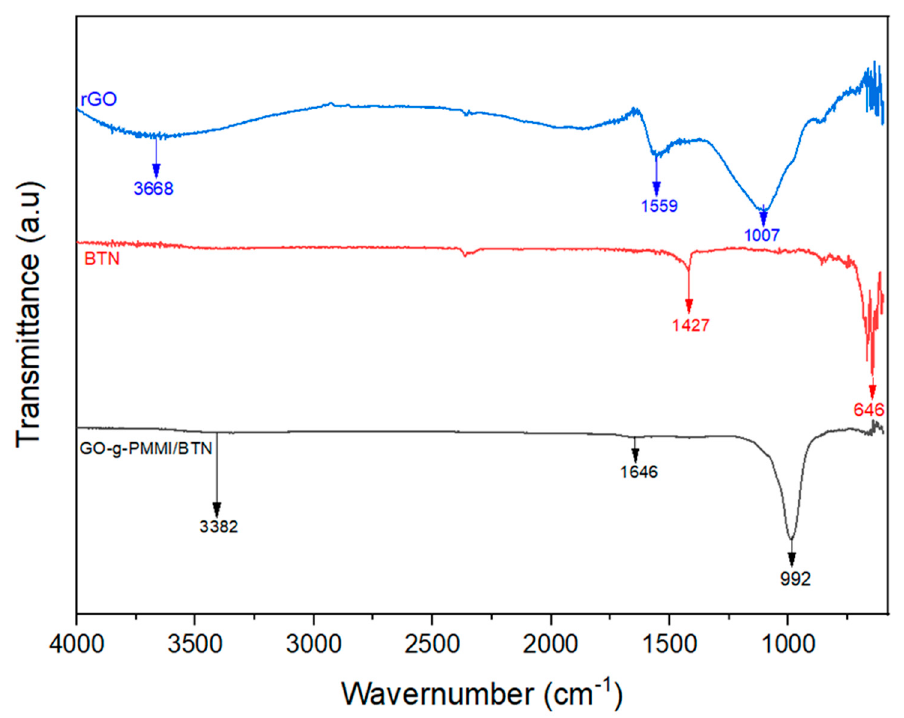
Figure 2. FTIR spectrum of rGO, BTN, and GO-g-PMMI/BTN. A wide absorption band between 3200 and 3600 in the spectrum of rGO is observed, which is attributed to the presence of hydroxyl groups [22]. Likewise, the absorption band at 1559 cm − 1 corresponds to the aromatic C=C, which indicates the presence of a conjugated sp 2 system [23]. Moreover, a band at 1007 cm − 1 corresponds to hydroxyl and ether groups [24].